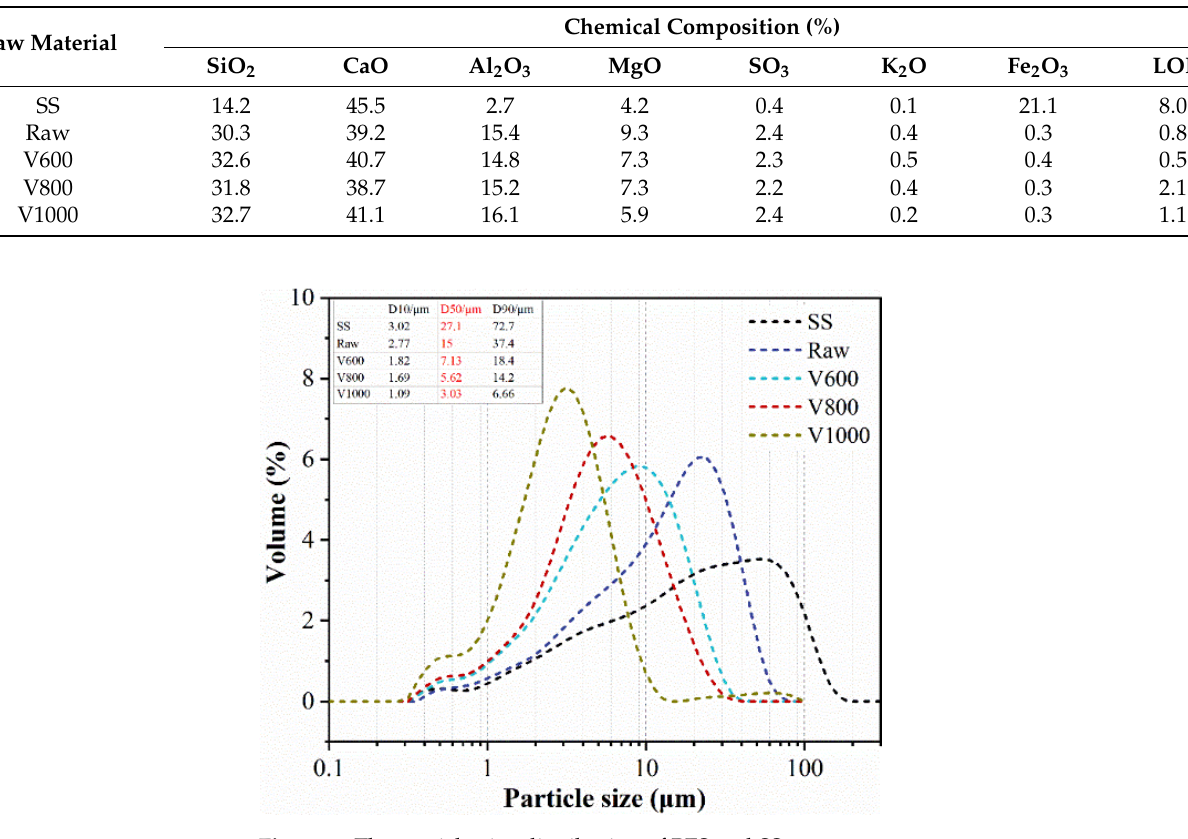
Figure 1. The particle-size distribution of BFS and SS.